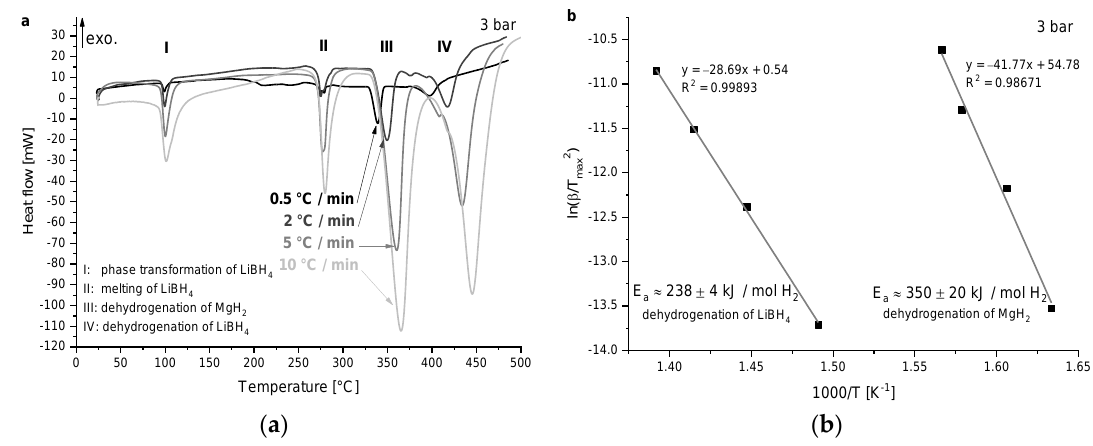
Figure 2. ( a ) Heat flow signal plotted vs temperature for four different heating rates at 3 bar of H 2 (desorption conditions) for the dehydrogenation of MgH 2 and LiBH 4 ; ( b ) The resultant Kissinger plots. The calculated values for the activation energies result in 350 ± 20 kJ mol − 1 H 2 and 238 ± 4 kJ mol − 1 H 2 for the dehydrogenation process of MgH 2 and LiBH 4 , respectively. The